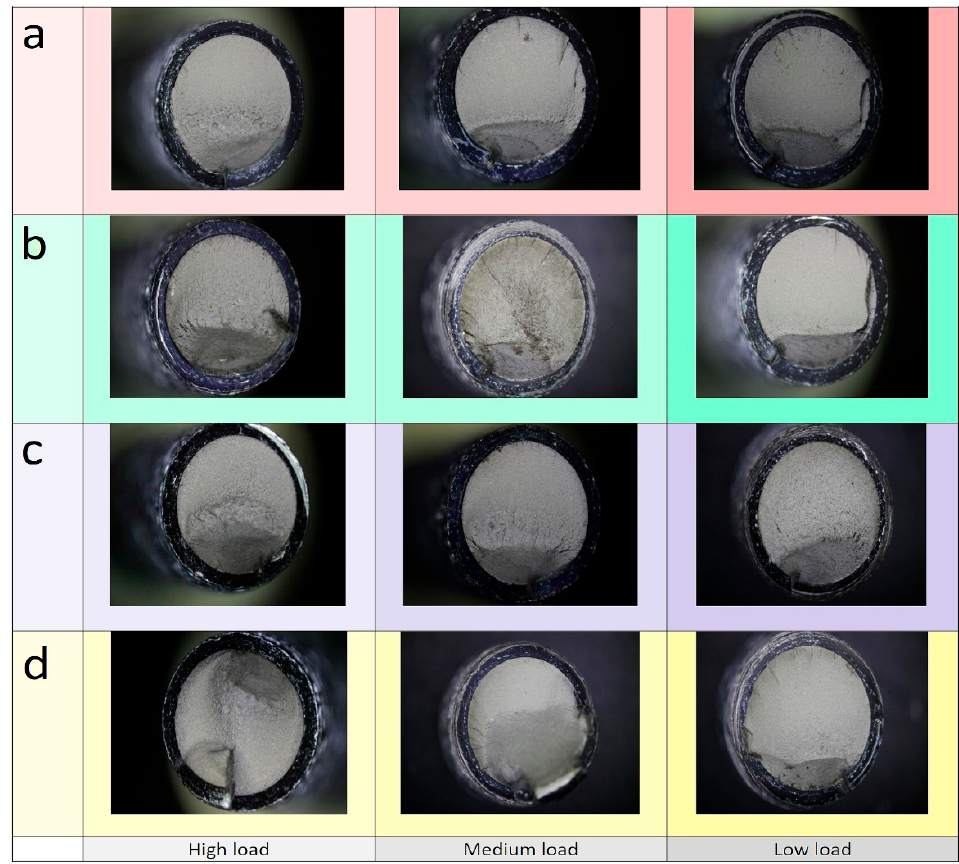
Figure 13. Fracture surface produced by different clamp lengths at high, medium and low loads. ( a ) levers of ( a/b ) 19/17 mm ( b ) levers of ( a/b ) 29/17 mm ( c ) levers of ( a/b ) 39/17 mm ( d ) levers of ( a/b ) 44/17 mm.